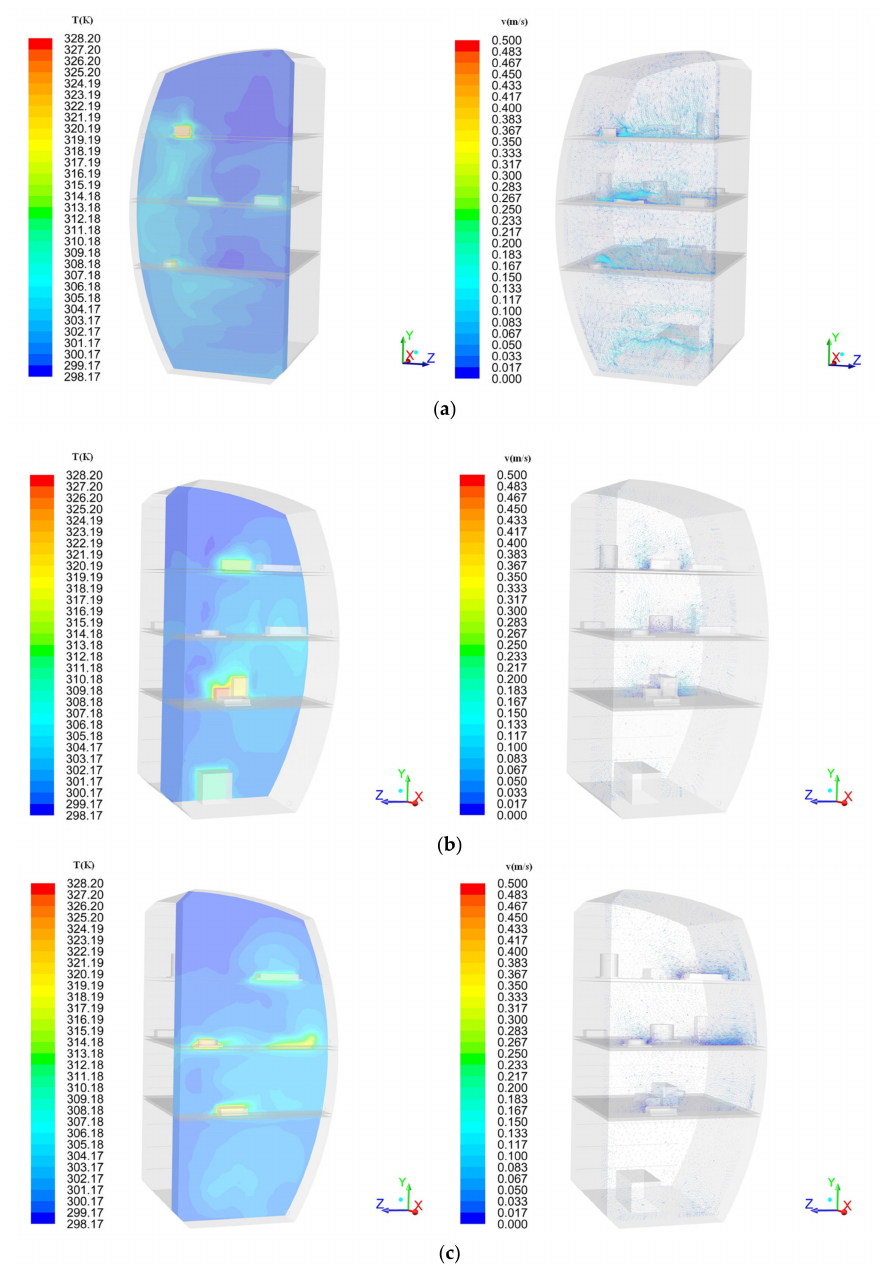
Figure 9. Temperature distribution and velocity vector of new air cooling system. ( a ) x = 120 mm, ( b ) x = 600 mm, and ( c ) x = 900